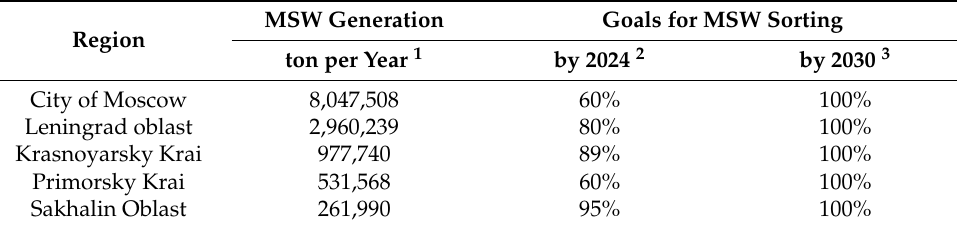
Table 1. MSW generation and goals for sorting in selected regions of the Russian Federation. MSW Generation Goals for MSW Sorting Region